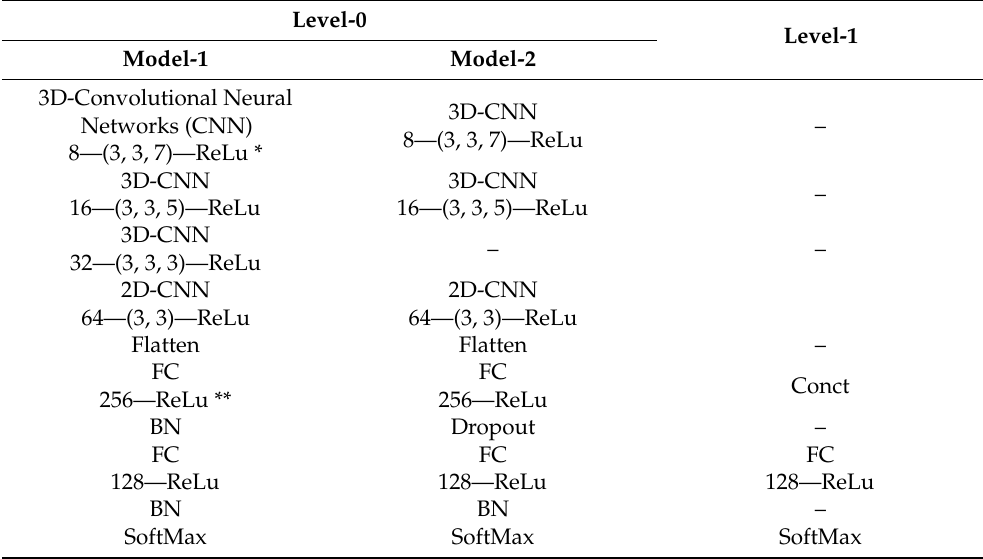
Table 1. The structure of the framework. level-1 layers for model-1 and model-2, and level-2 layers.